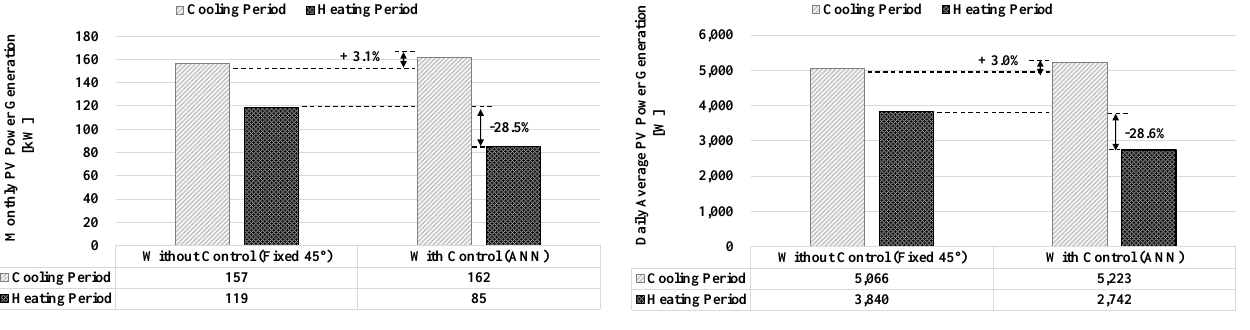
Figure 17. PV power generation with and without ANN optimal control.